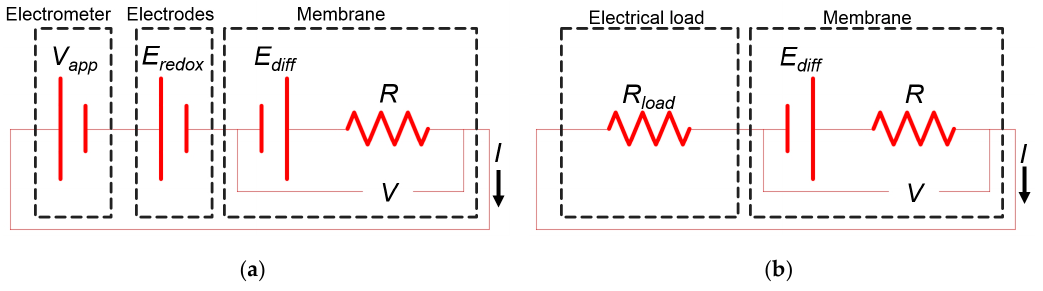
Figure 5. Two electrical circuits represent the experimental setup.